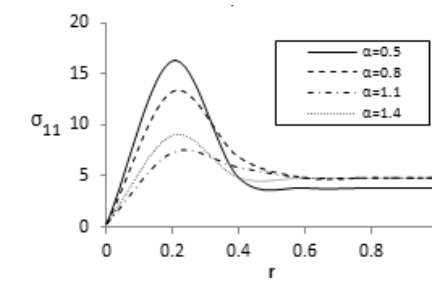
Figure 1: Distribution of radial stress with the radius